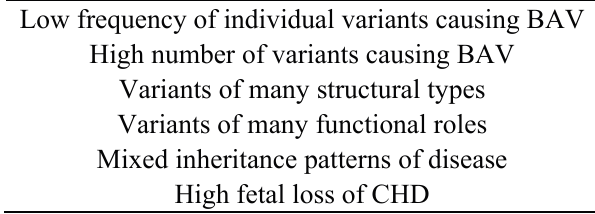
Table 1. Factors that may confound discovery of BAV-associated